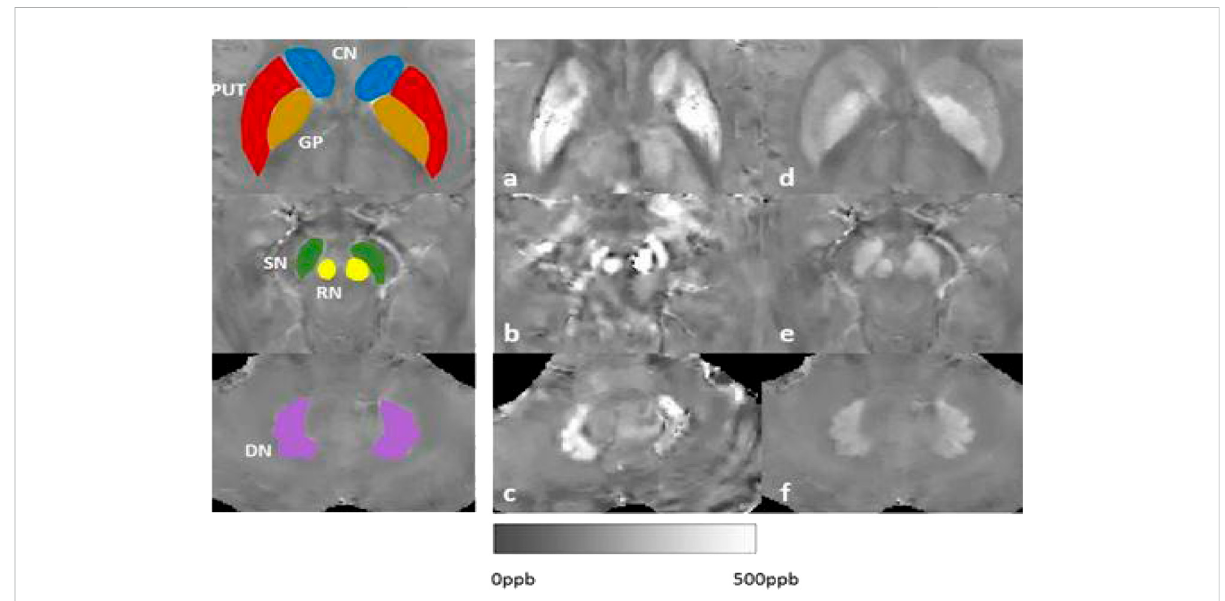
Our results of MRI-QSM signals: iron/copper related Magnetic Susceptibility in the Deep Gray Matter Nuclei of Wilson ’ s Disease. Note: CN: caudate nucleus; GP: globus pallidus; PUT: putamen; SN: substantia; RN:rednucleus; DN: dental